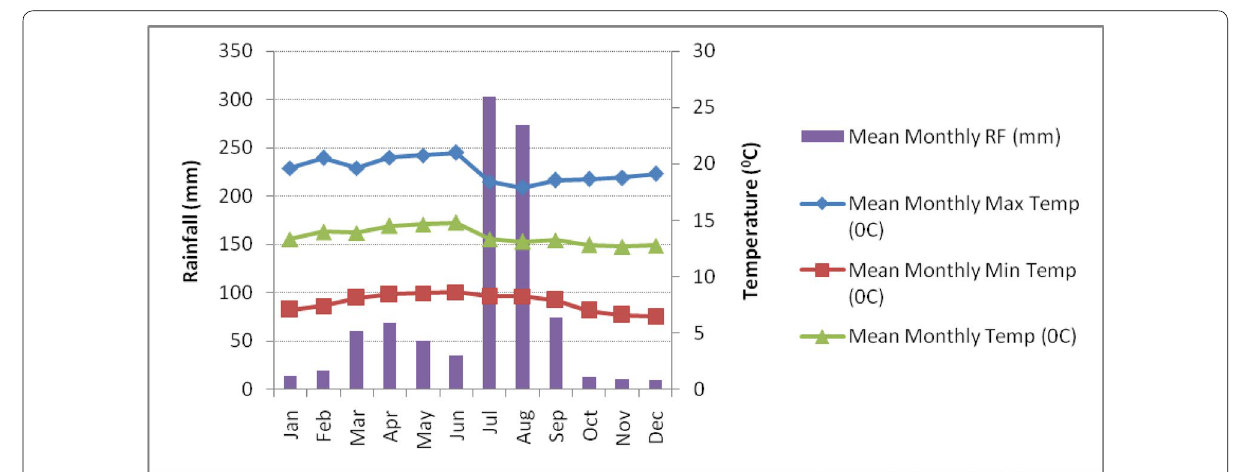
Fig. 3 Mean monthly maximum and minimum temperature and mean monthly rainfall records 1984–2017, from Ambamariam meteorological station (3000 m), South Wello ,